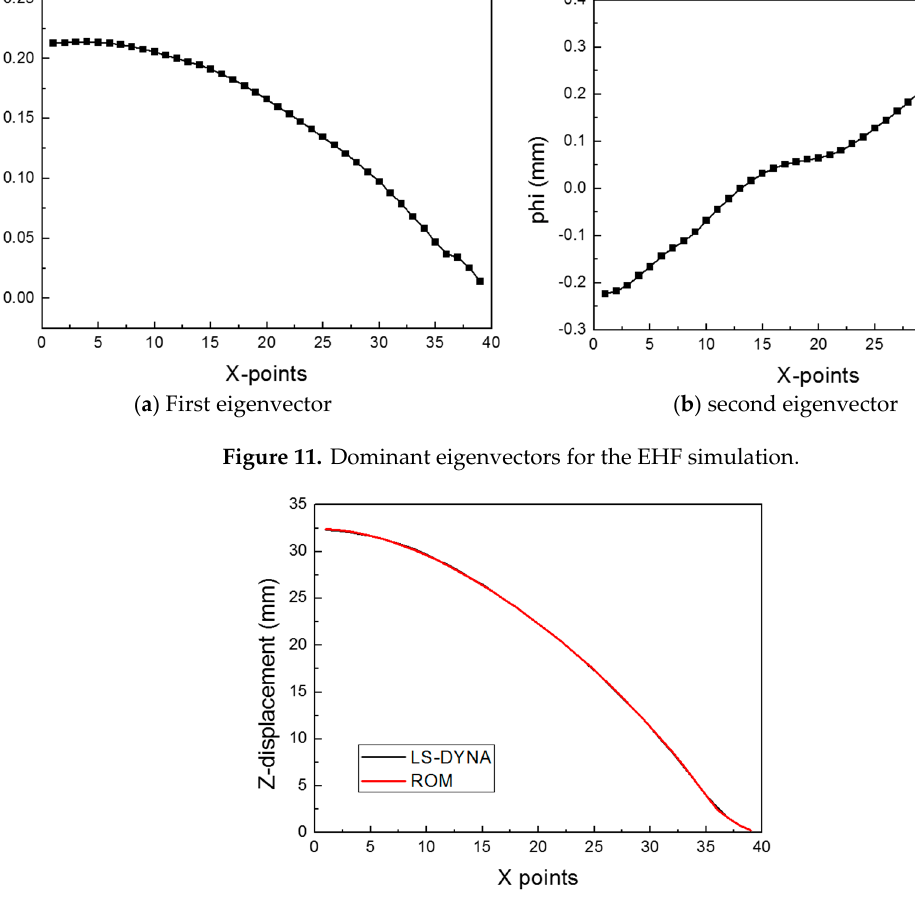
Figure 12. Comparison of LS-DYNA and ROM for Case 1.